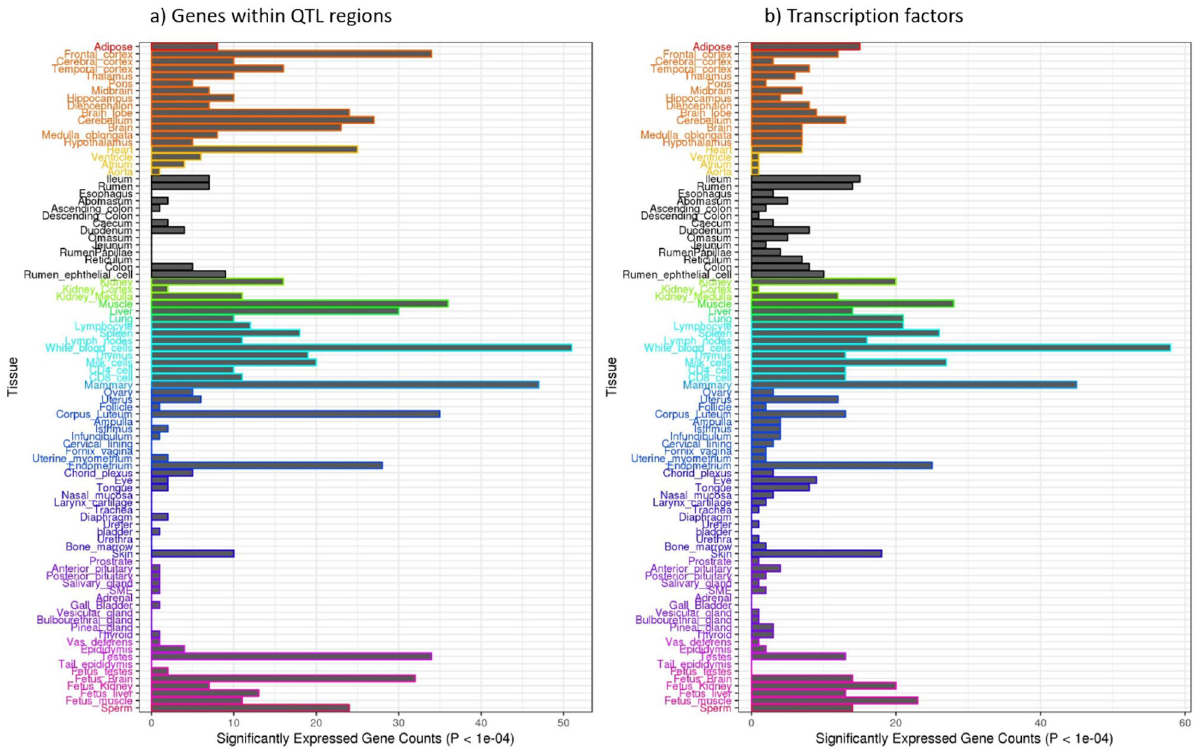
Figure 4. Counts of significantly expressed genes ( P < 10 −4 ) in 91 tissues, showing ( a ) positional candidate genes and ( b ) transcription factors identified as putative regulators of these